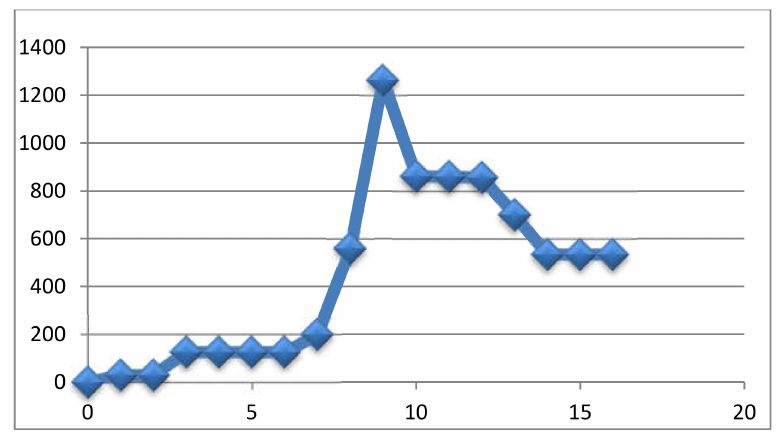
Figure 9. EGT Margin—disembarks graph.